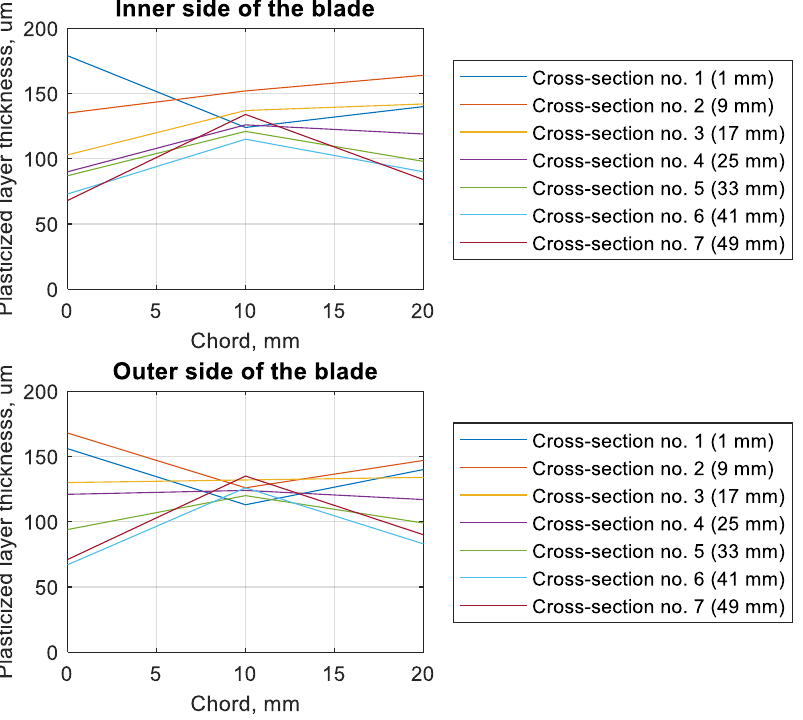
Figure 9. Plots of plasticized layer thickness (by shot-peening) as a function of the height of the blade for different measurement location.